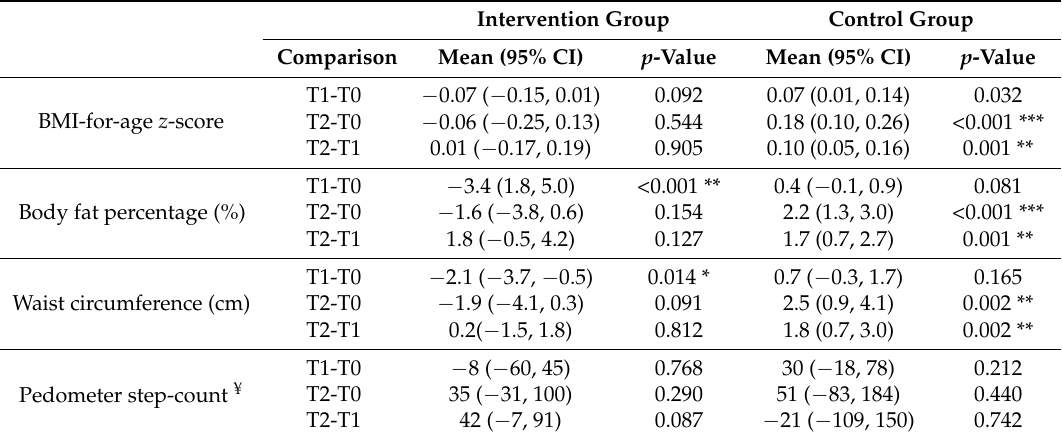
Table 3. Nine-month changes in all outcome measures within-group (n =